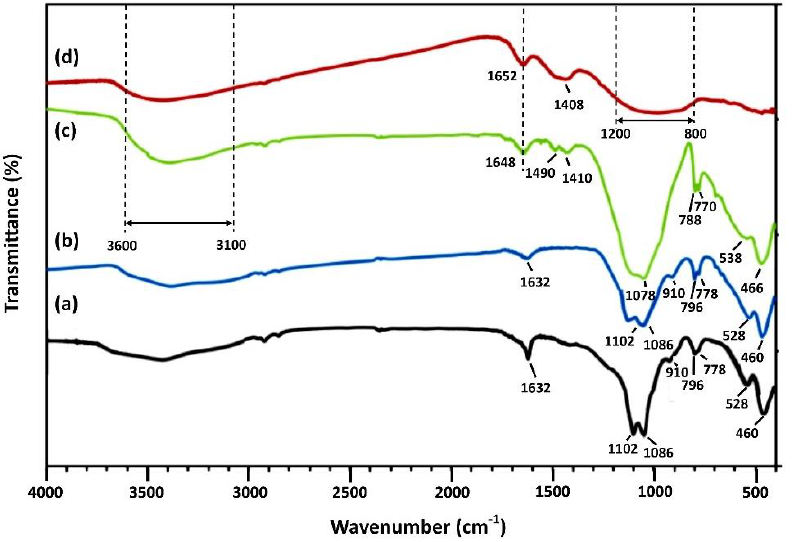
Figure 8. FTIR spectra of ( a ) laterite leaching residues and AAMs produced using ( b ) only leach- ing residues (LR2 AAM) as well as by mixing ( c ) leaching residues and metakaolin at mass ratio 90:10 (LR90MK10) and ( d ) LR90MK10 after firing at 800 °C for